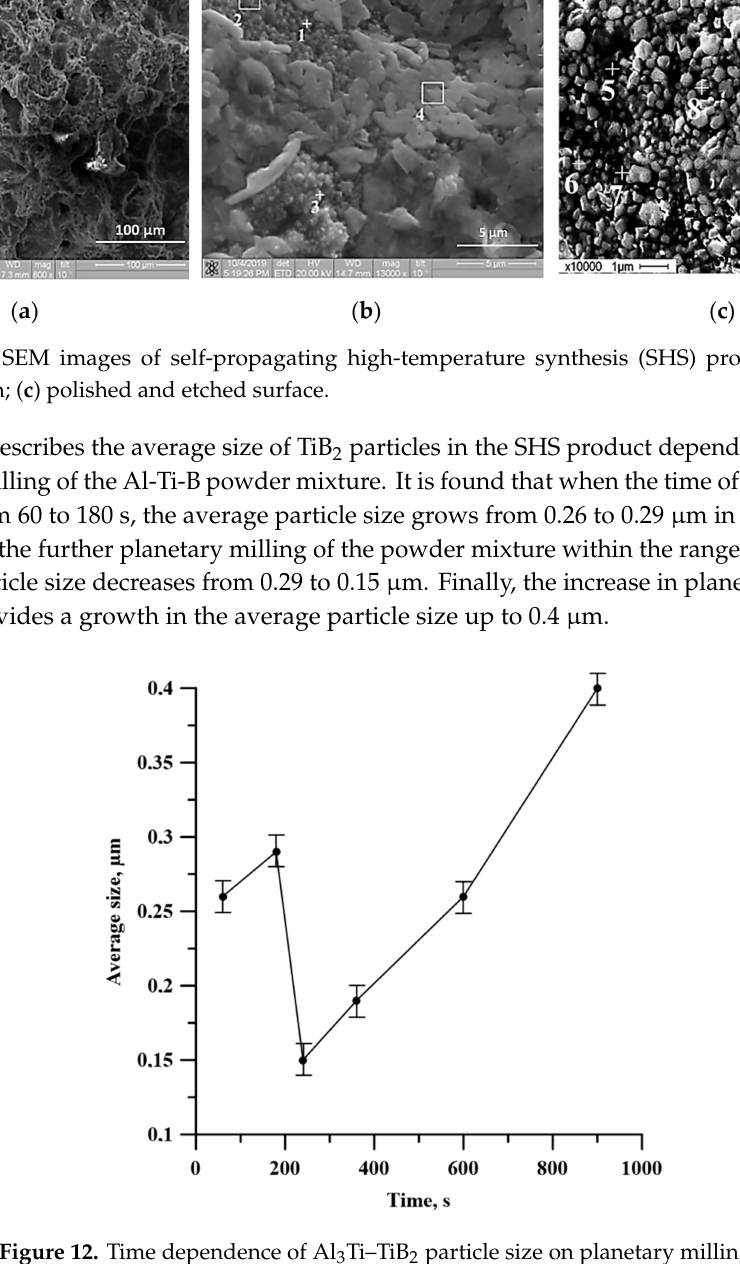
Figure 12. Time dependence of Al 3 Ti–TiB 2 particle size on planetary